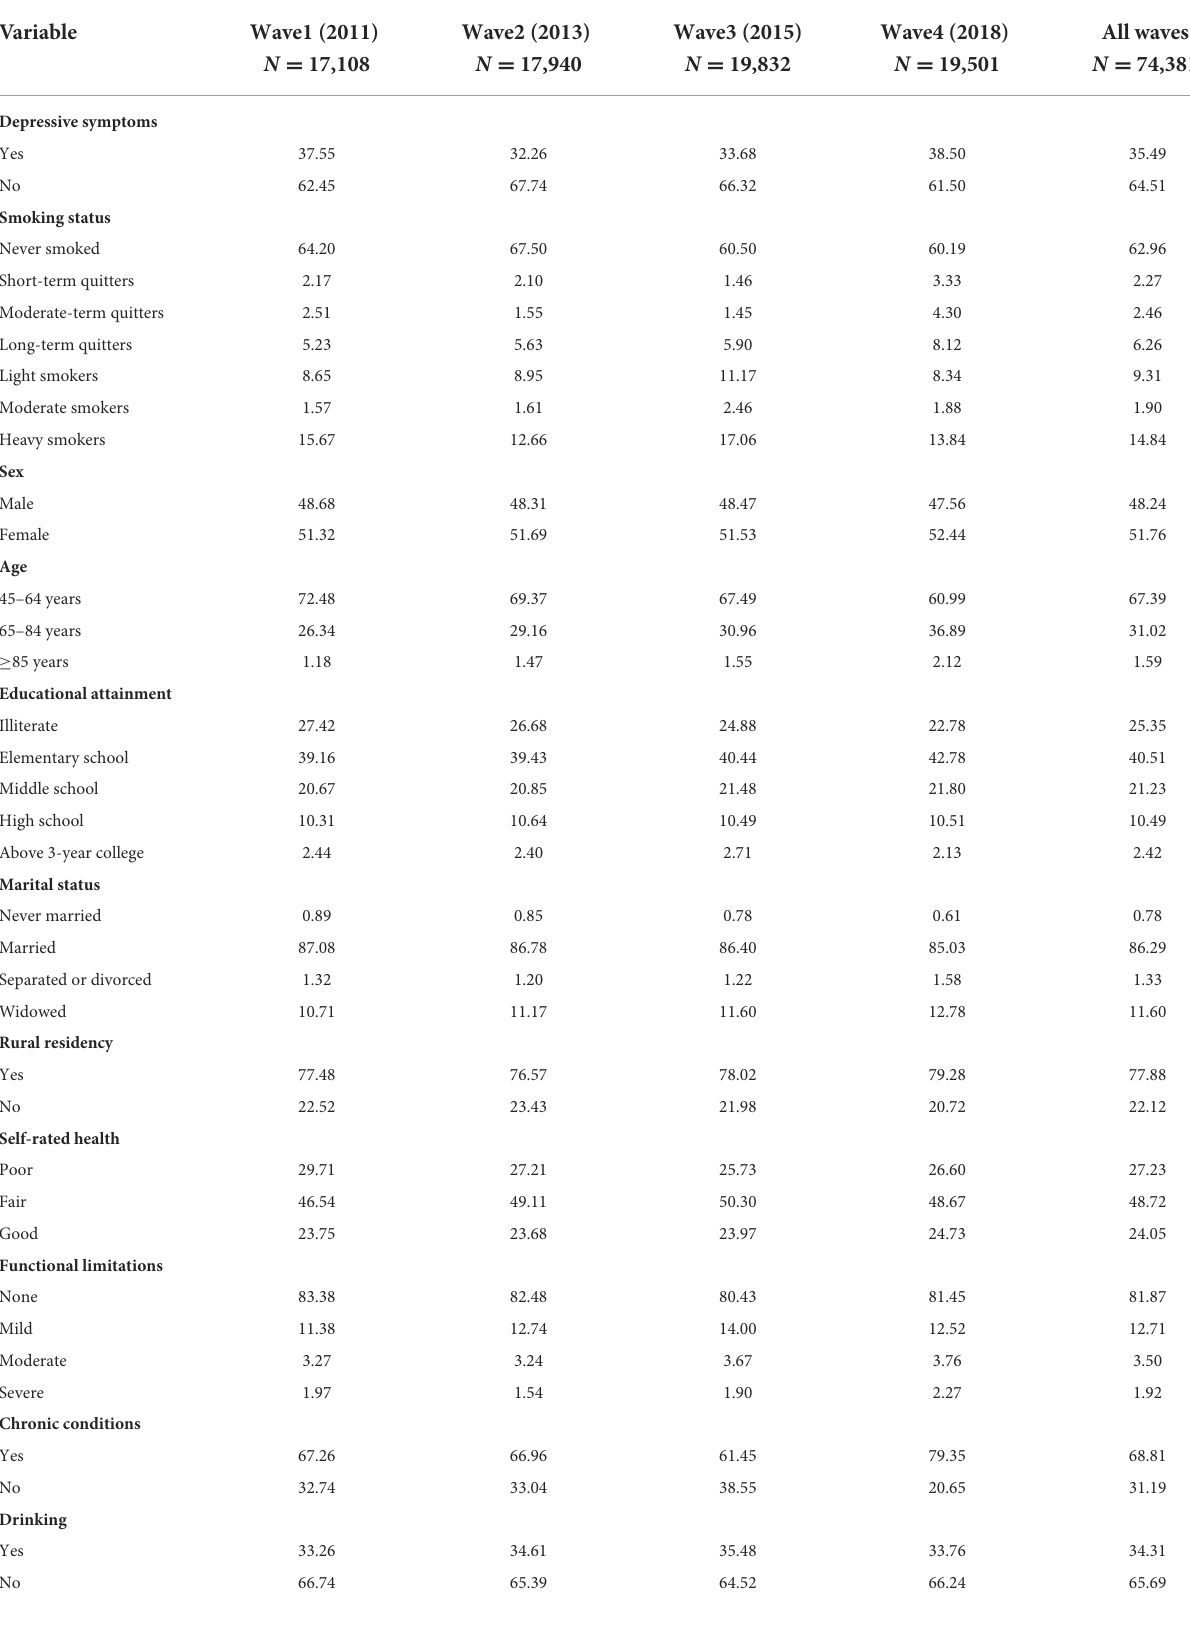
TABLE 3 Description of variables in four waves